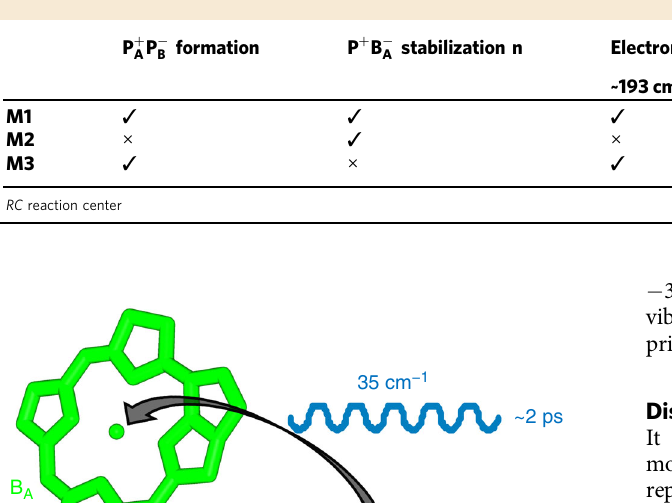
Table 1 The behavior of the three mutant RCs